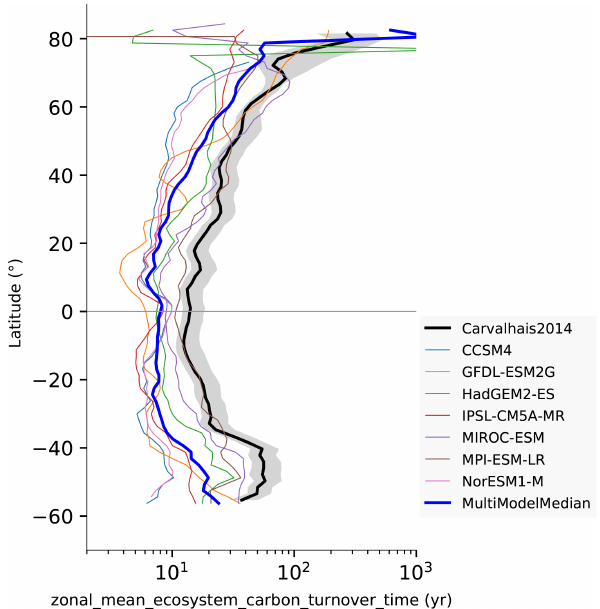
Figure 36. Zonal distribution of ecosystem turnover time of car- bon (in years). The zonal values are calculated as the ratio of total carbon stock and the gross primary productivity per latitude. The in- dividual models are plotted as thin coloured lines, the multi-model ensemble as a thick blue line, and the observation-based estimate (Carvalhais et al., 2014) as a thick black line with shaded region showing the observational uncertainty. The median of all models is adopted as the multi-model ensemble. Note the logarithmic hori- zontal axis. Produced with recipe_carvalhais2014nat.yml ; see de- tails in Sect.